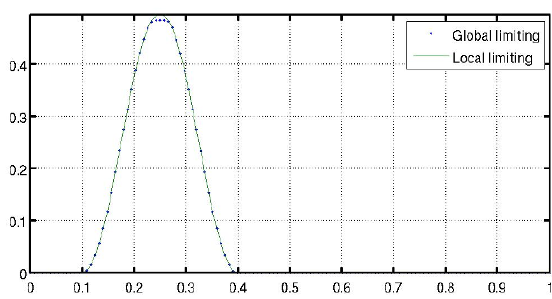
Figure 4. Solid body rotation: FEM-FCT solution profiles at y